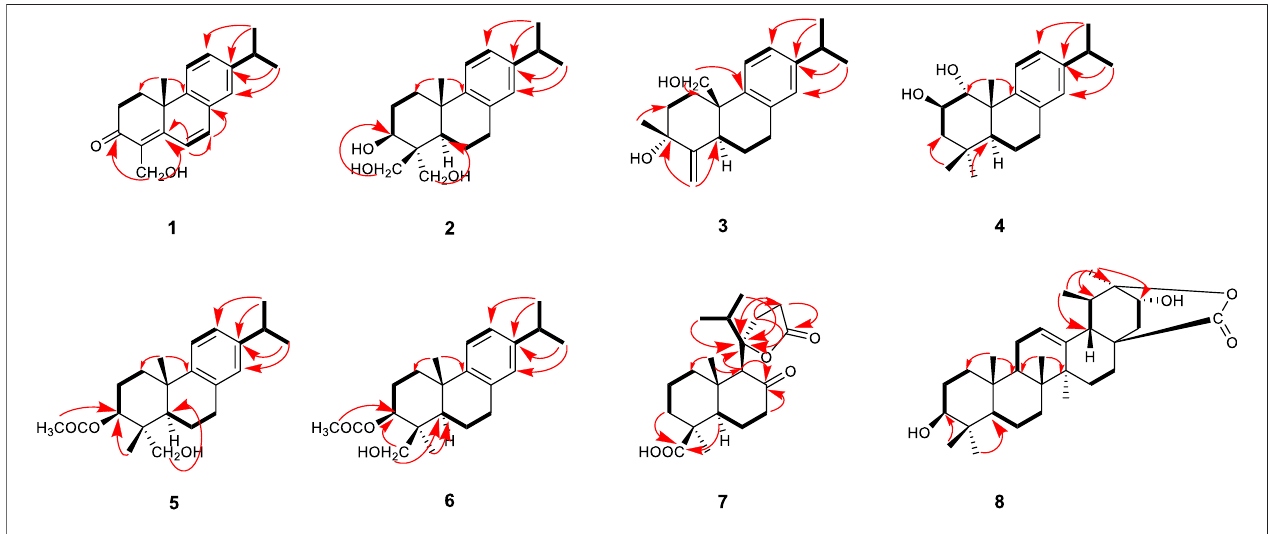
FIGURE 2 | Key HMBC (arrows) and 1 H − 1 H COSY (bold lines) correlations for compounds 1 – 8 .